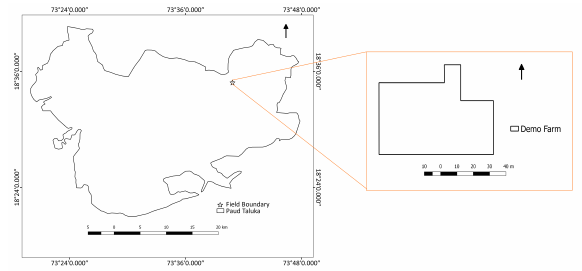
Figure 2. Validation Site: TCS demo farm located in Pune, India